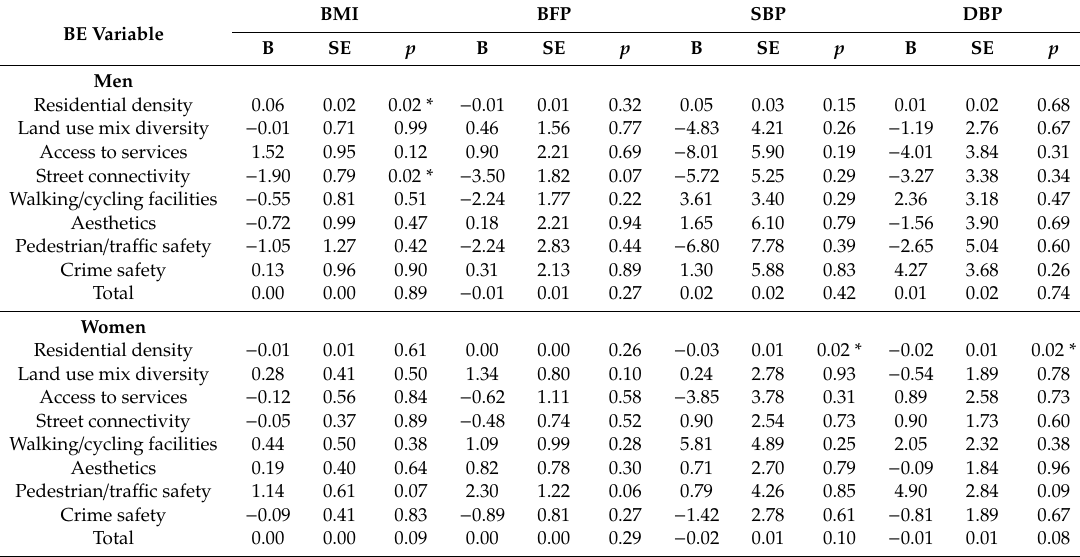
Table 4. Association b between BE and BMI, BFP, SBP, and DBP.